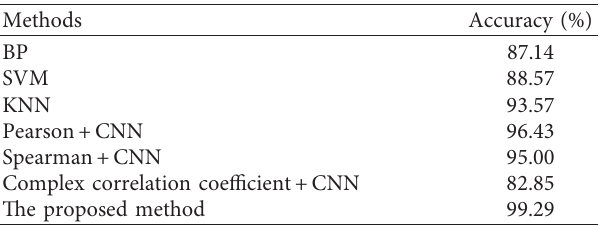
Table 4: Comparison of test accuracy from different diagnostic